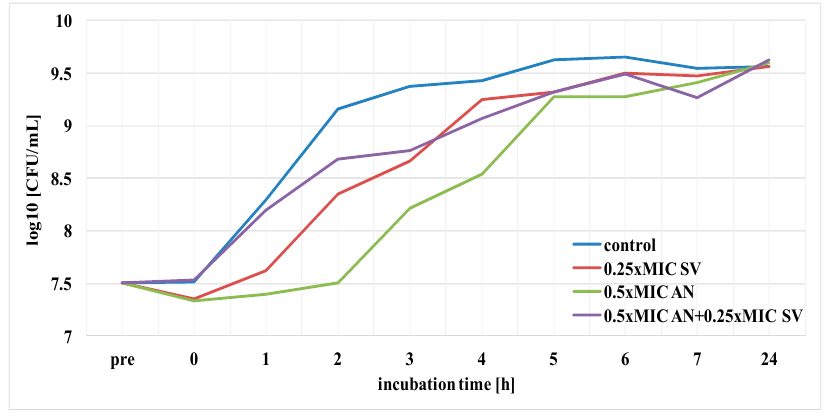
Figure 6. PASME of ciprofloxacin (CIP) against E. coli in the presence of S. virgaurea extract (SV).